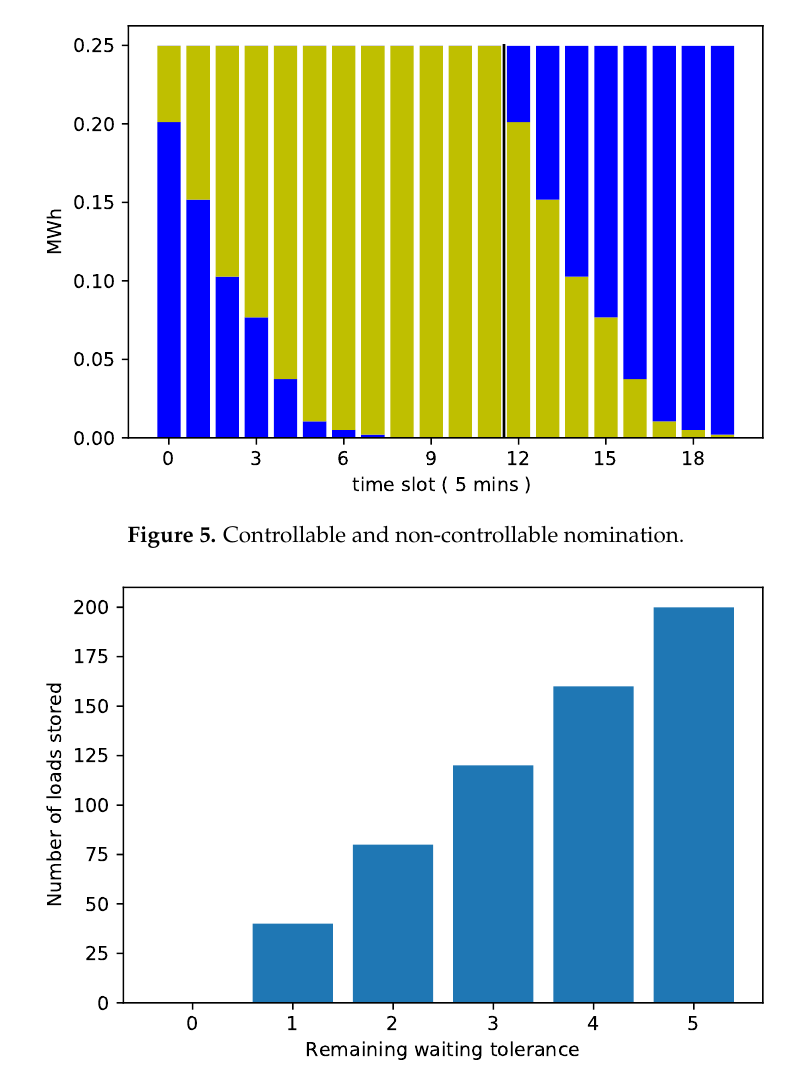
Figure 6. Initial buffer